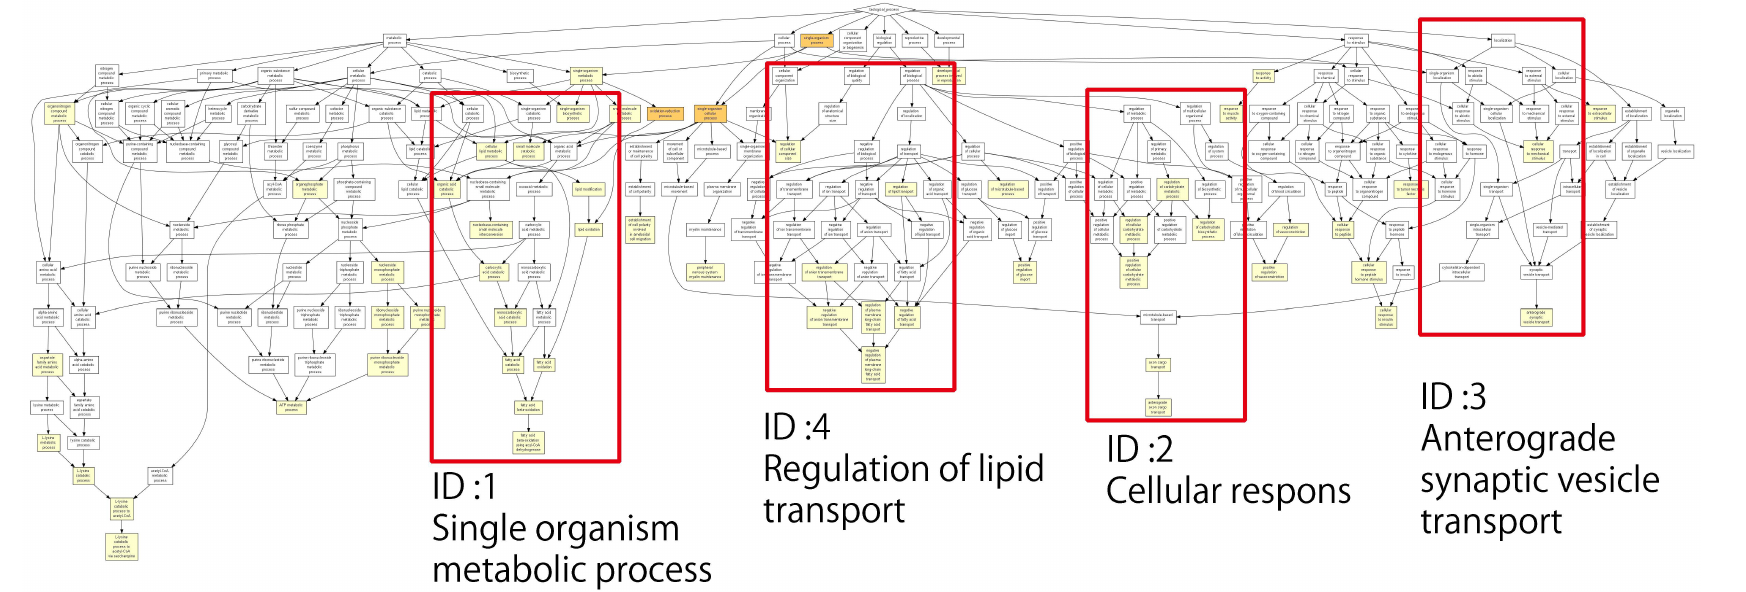
Figure 3. Functional analysis using the Gene Ontology (GO) enrichment test. The related processes and relationships of a number of identified genes are shown. The lower the p -value, the larger the difference in expression level compared with the reference. p -values are color coded as follows: white, > 10 − 3 ; light orange, 10 − 3 to 10 − 5 ; orange, 10 − 5 to 10 − 7 ; dark orange, 10 − 7 to 10 − 9 ; red, < 10 − 9 . The next graph was created by considering the process with the lowest p -value from the lower layer of each extracted process and then displaying it in a graph. The ID shows its location in Figure 3. ID4 mainly represents the removed processes that relate to fatty acids, and also one process that was removed regardless of its p -value as an